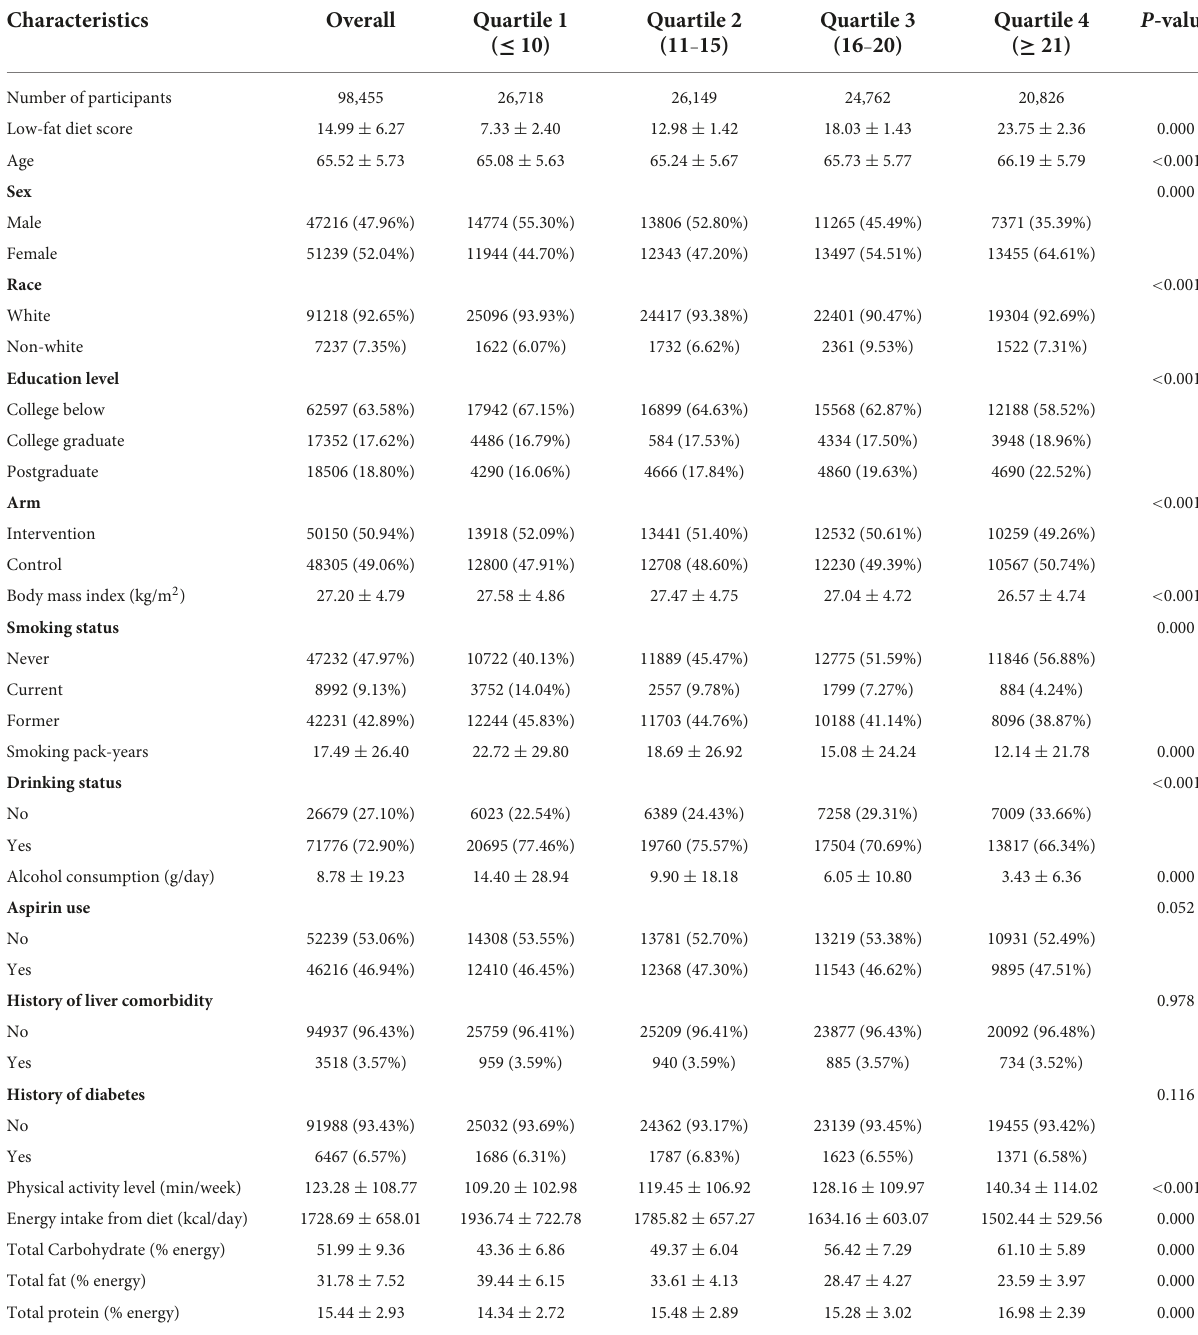
Quartiles of overall low-fat diet